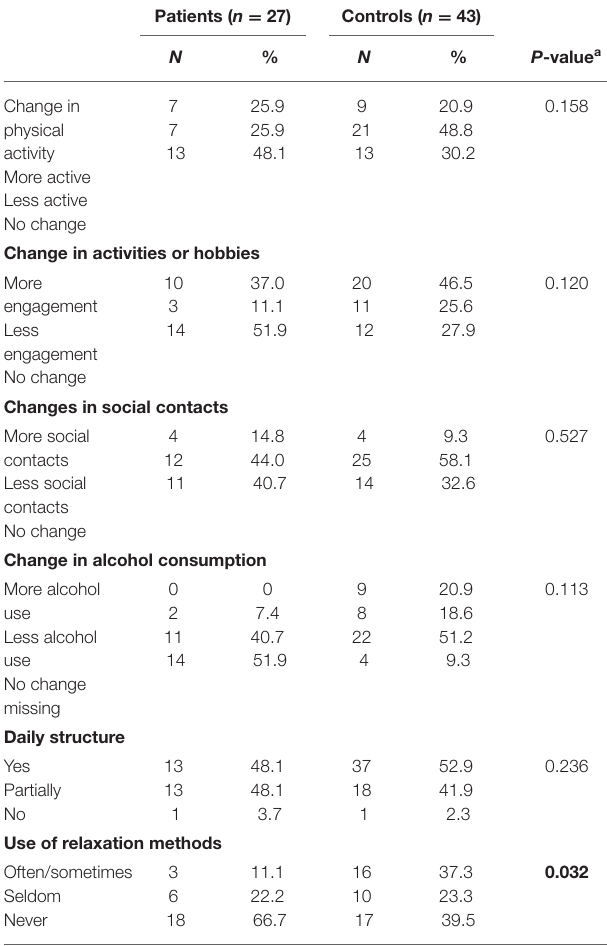
TABLE 4 | Lifestyle factor changes due to the pandemic. Patients ( n =